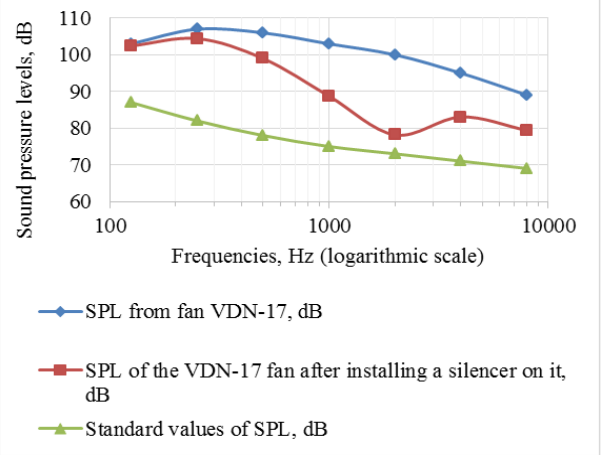
Fig. 2. Noise characteristic in the measuring area around the body before and after installing the muffler